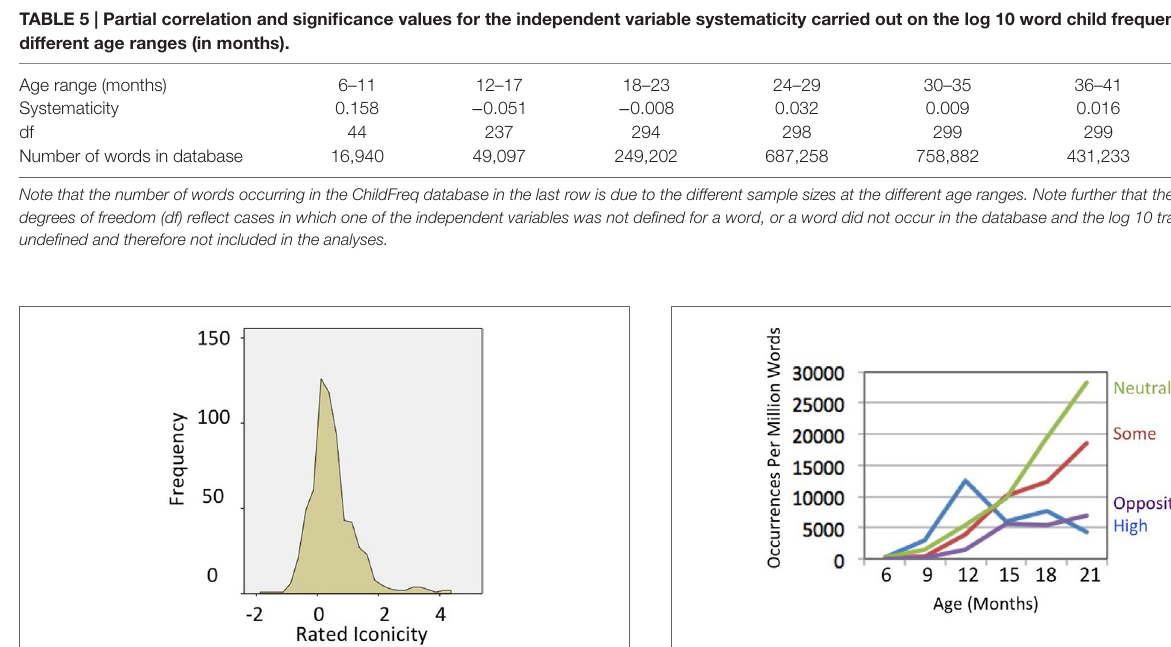
TaBle 5 | Partial correlation and significance values for the independent variable systematicity carried out on the log 10 word child frequency at seven different age ranges (in months).